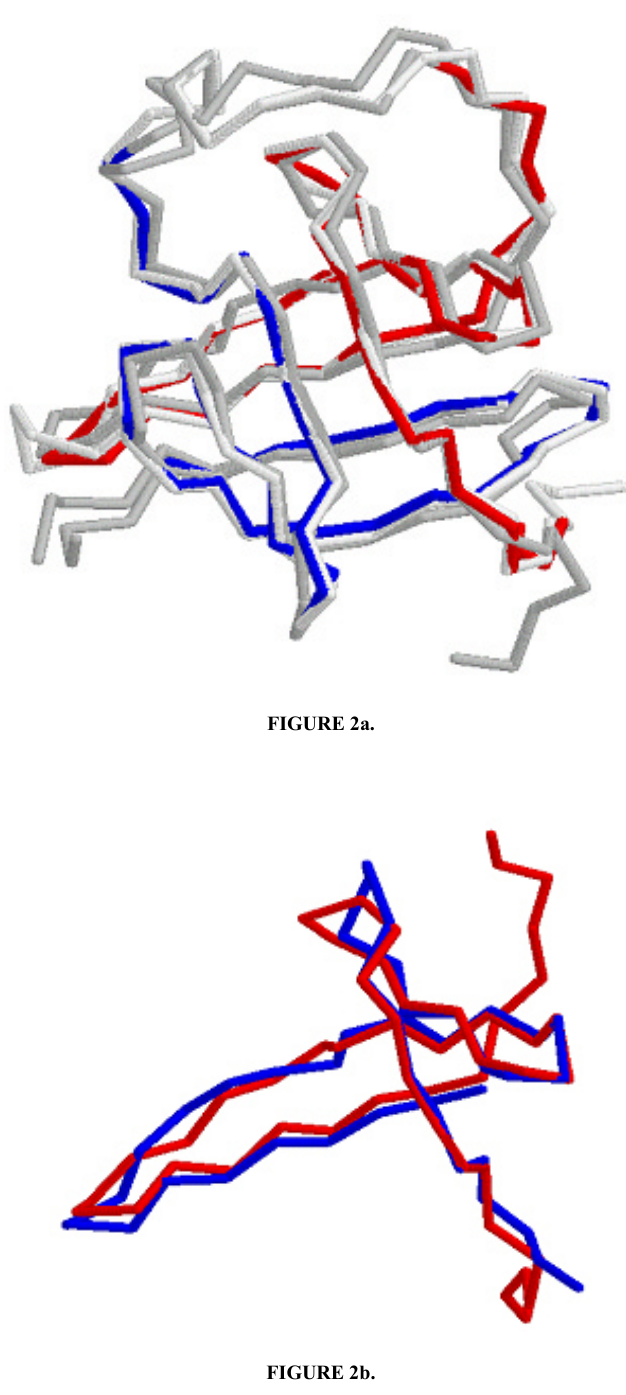
FIGURE 2. Superposition of alpha carbon backbone atoms of the Tcl1 family members: mouse Tcl1 (red for residues 8-57, blue for 67-108), human Tcl1 (white), and human Mtcp1 (gray). The red/blue color scheme is shown to emphasize the half-barrel structure shown in (B). Two tandem halves of mouse Tcl1 structure superimposed to show the internal symmetry (B). Residues 8-57 (red) and 67-108 (blue) are